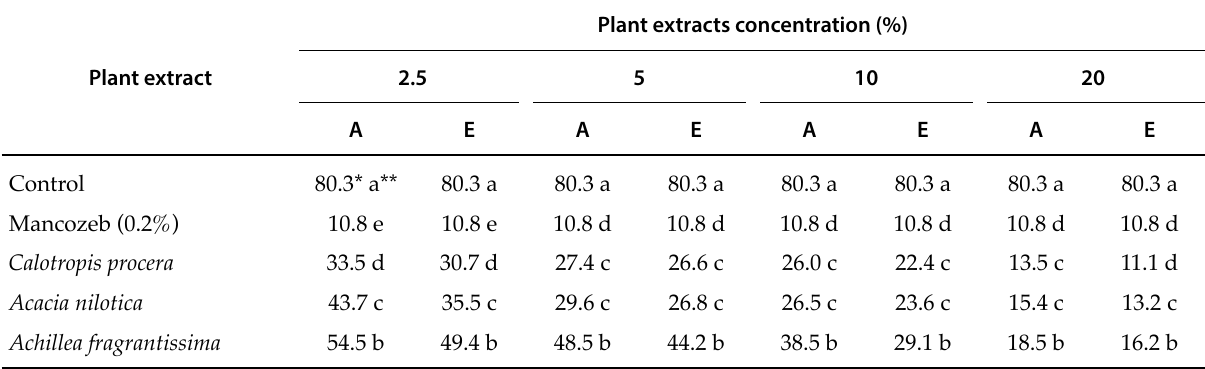
Table 2. Mean percent germination of Alternaria solani conidia exposed to different concentrations of fungicide, or aqueous (A) or ethanol (E) extracts from three different plants at different concentrations.